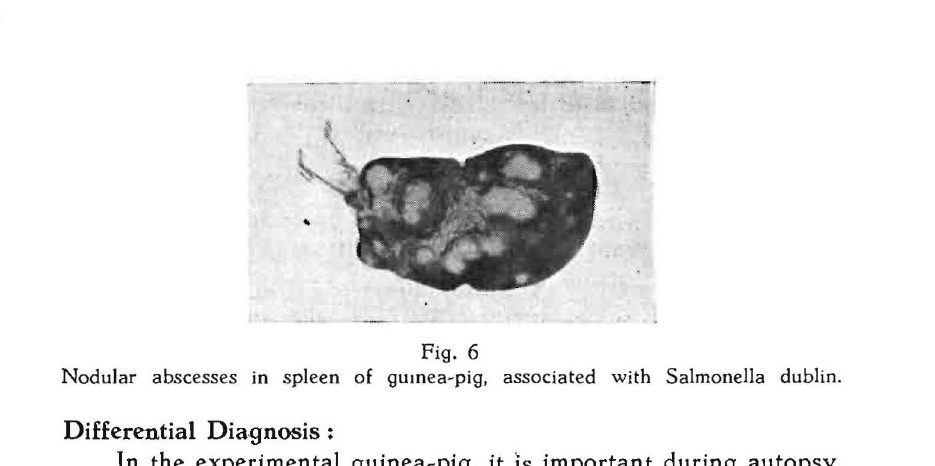
Fig. 6 Nodular abscesses in spleen of gUinea-pig, associated with Salmonella